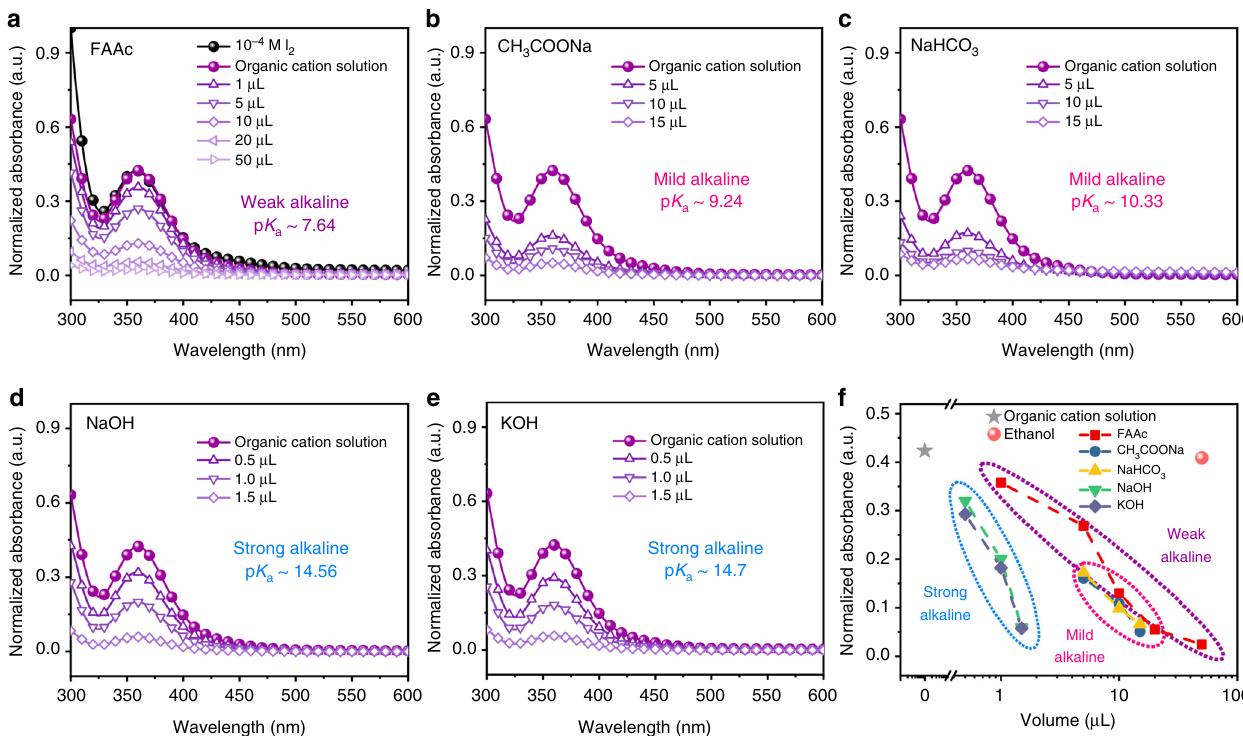
Fig. 1 Suppression of I 2 impurity via alkaline additives. UV-vis absorption spectra of the organic cation solution, which is used to prepare the perovskite fi lms, with different amounts of ( a ) FAAc, ( b ) CH 3 COONa, ( c ) NaHCO 3 , ( d ) NaOH, and ( e ) KOH ethanol solution. f Normalized absorbance for organic cation solution with different additives as a function of the